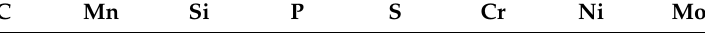
Table 1. Chemical composition of bearing steel 100CrMnSi6-4 (wt%).